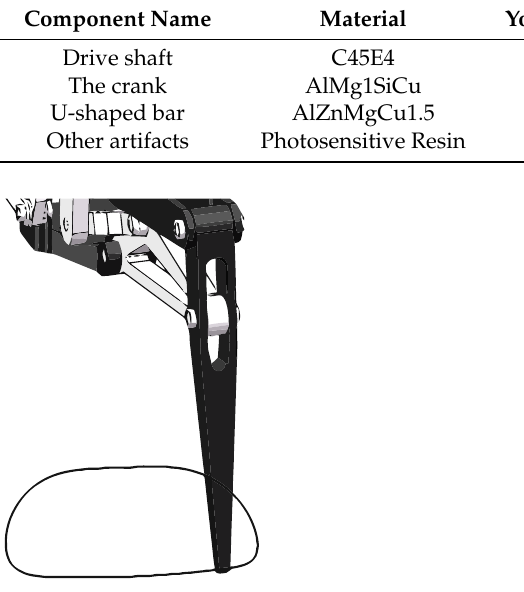
Figure 15. Foot simulation trajectory.